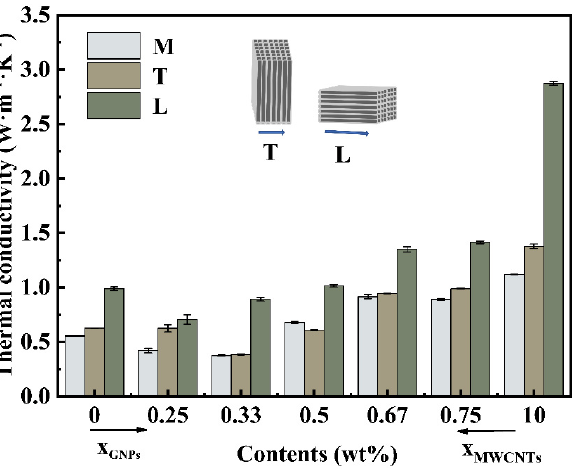
Figure 6. Thermal conductivity of two-component filled samples with different ratios and different forming methods.